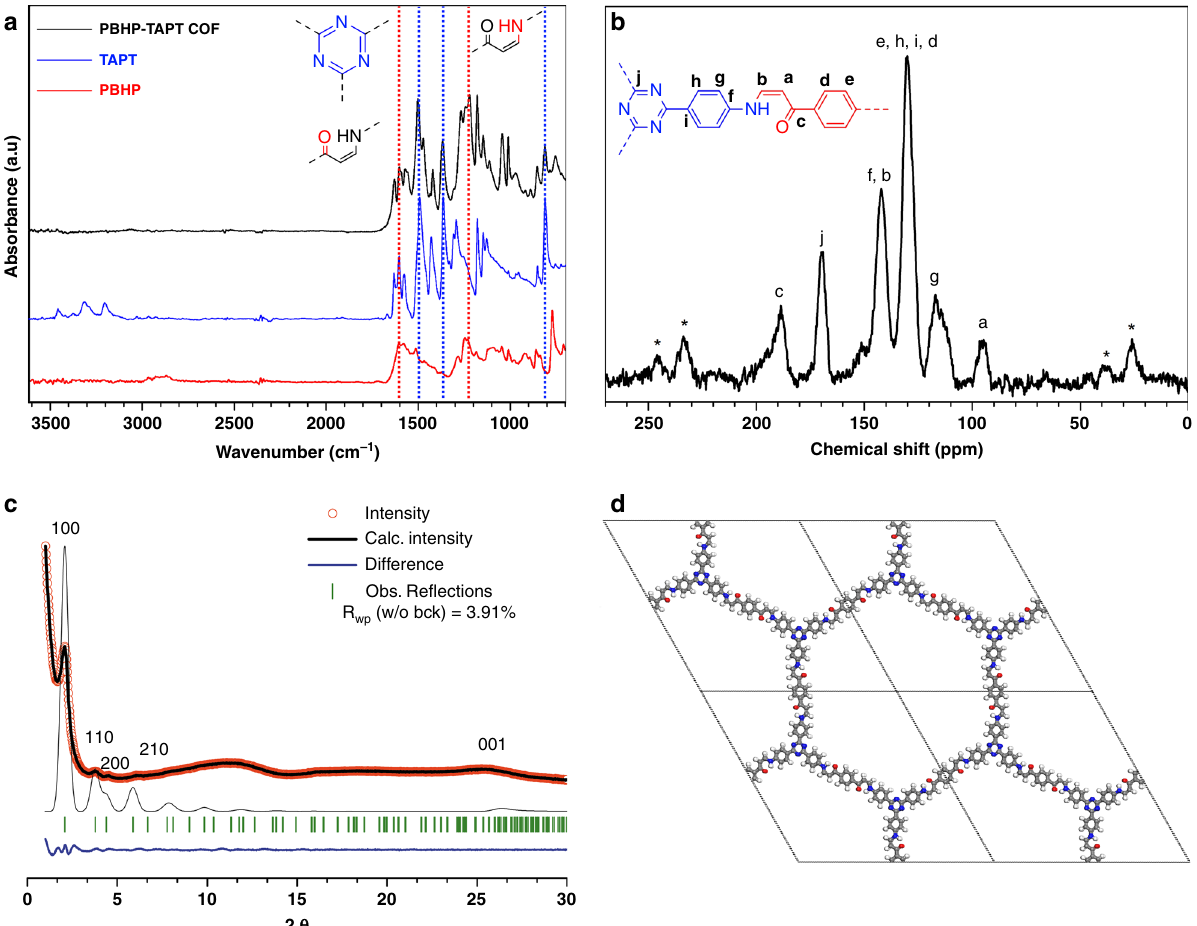
Fig. 2 Physical characterization of PBHP-TAPT COF. a Comparison of the Fourier-transform infrared (FT-IR) spectra of PBHP-TAPT COF (in black) with its building blocks TAPT (in blue) and the PBHP (in red). b 13 C cross-polarisation (CP) magic angle spinning (MAS) NMR (MAS rate of 13 kHz) of PBHP-TAPT COF. Spinning sidebands are marked with asterisks (*). c Experimental (red circles), Pawley re fi ned (thick black line), and predicted (thin black) PXRD patterns of PBHP-TAPT COF. Bragg peak positions (green), and the difference plot (experimental minus re fi ned; blue). d 2 × 2 unit cells (a = 44.2785 Å, c = 3.3767 Å, space group 174) of PBHP-TAPT COF with the principal unit cell (black dashes). Carbon (grey), hydrogen (white), nitrogen (blue), oxygen (red) atoms are represented as